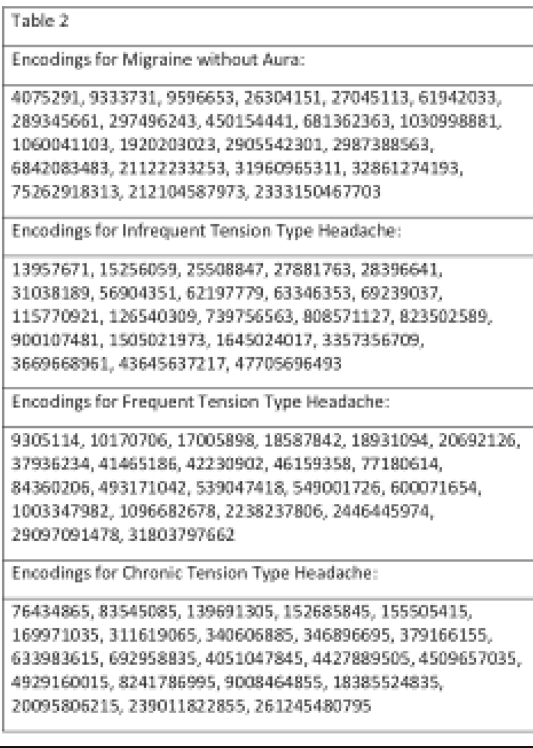
Title: Health care indicators for patients with headache at the emergency department during the COVID pandemic